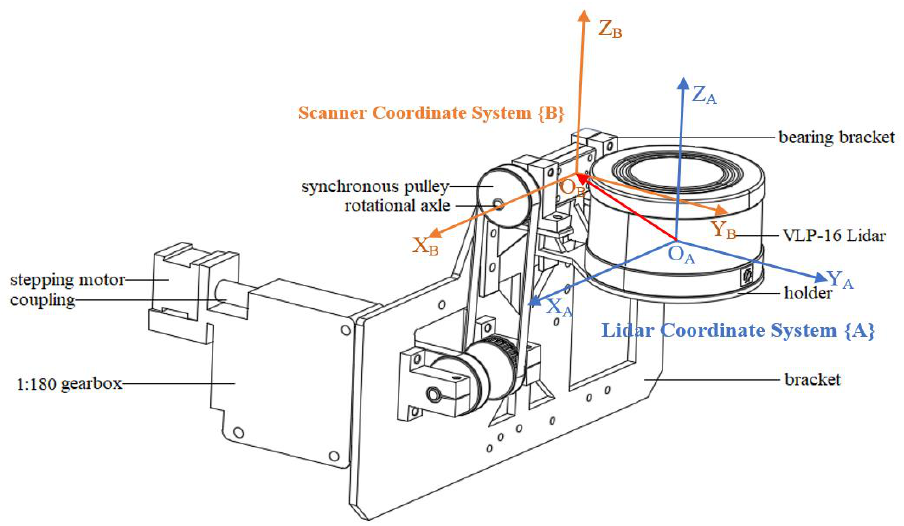
Figure 3. Mechanical design of the dense scan system.